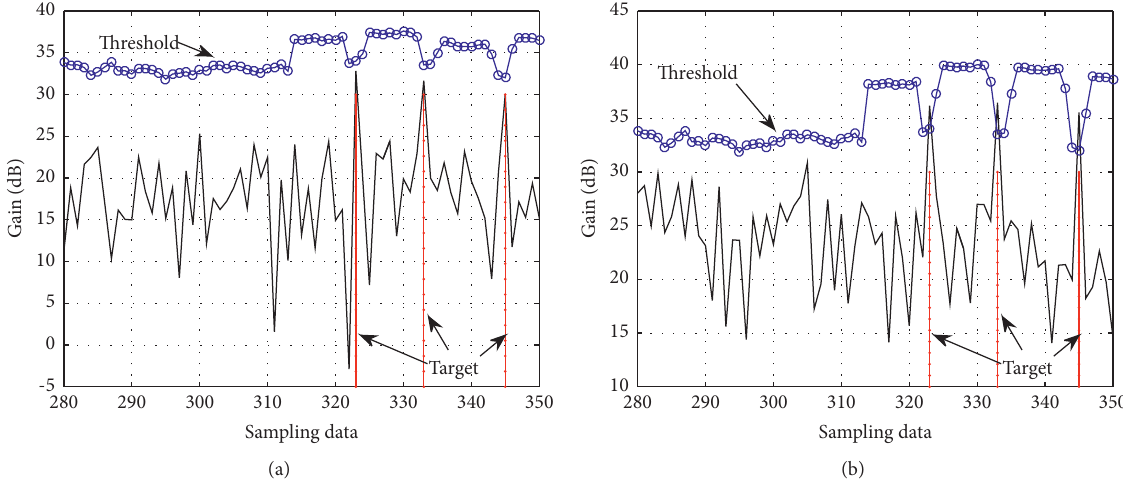
Figure 6: Comparison of output gain amplitude. (a) The gain of CA-CFAR. (b) The gain of the proposed incoherent integration detection method.